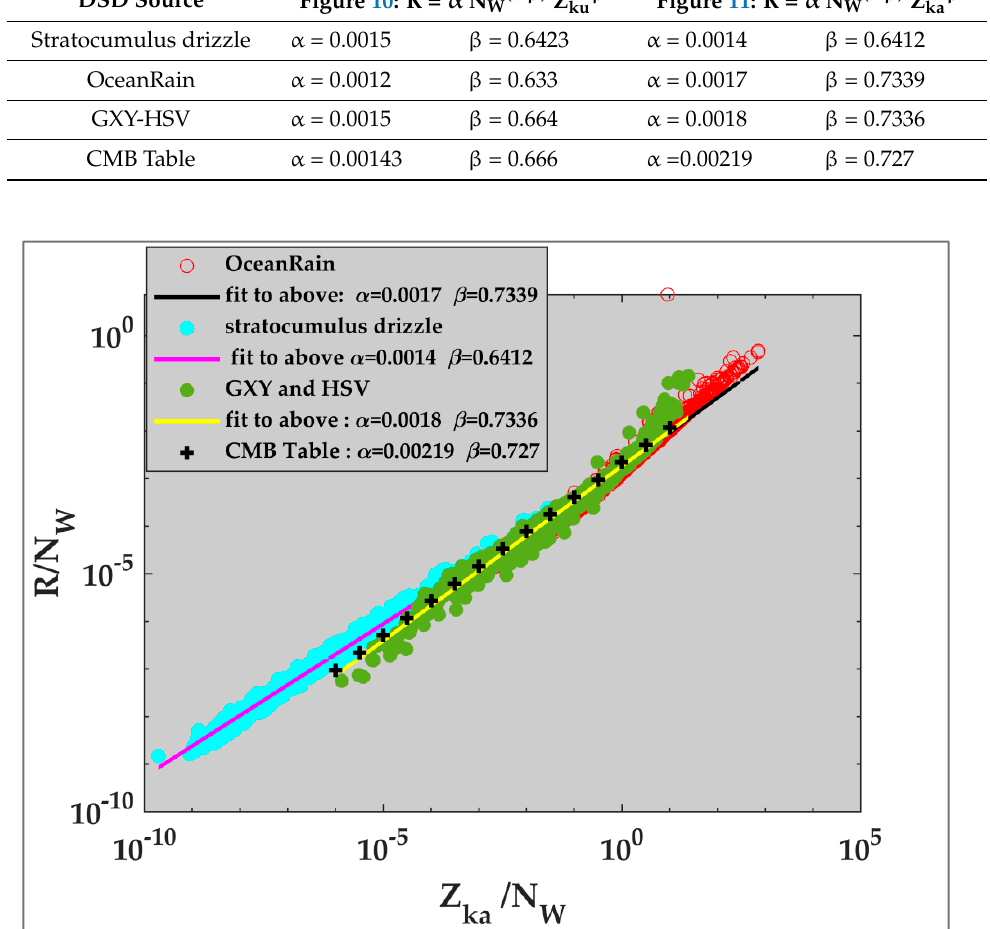
Table 2. Fitted coefficient α and the exponent β , corresponding to Figures 10 and 11. DSD Source Figure 10: R = α N W(1- β ) Z ku β Figure 11: R = α N W(1- β ) Z ka β